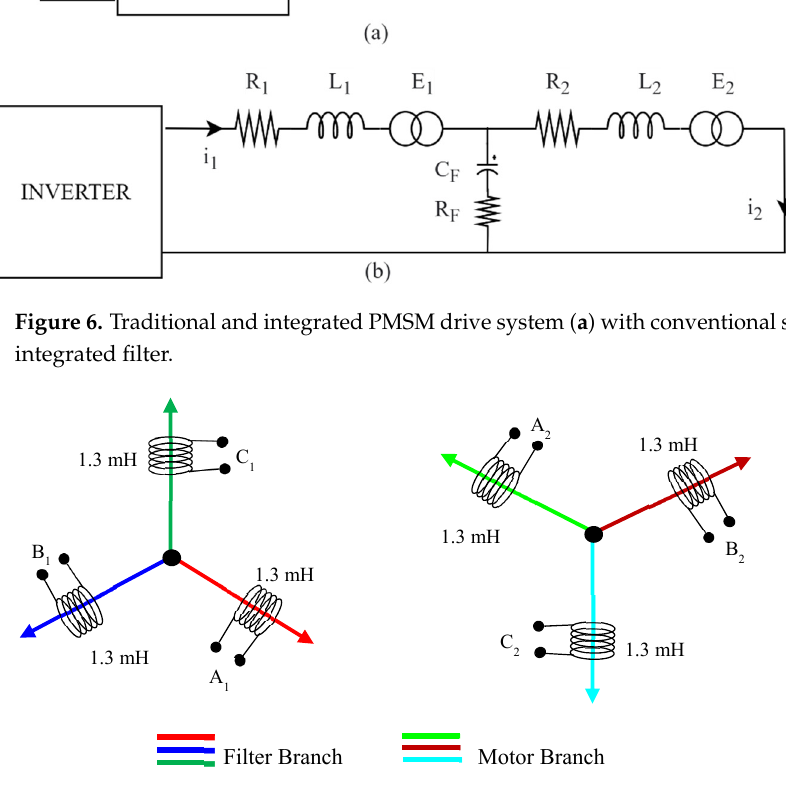
Figure 7. FE Model of Integrated Motor; showing filter and motor branches.